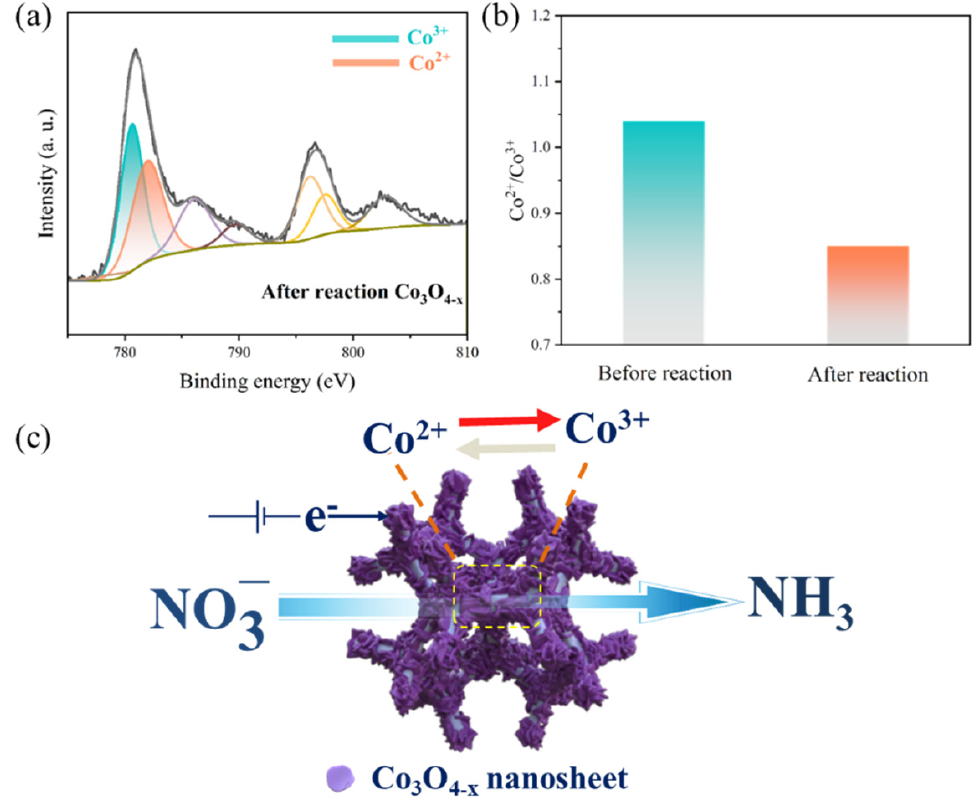
Figure 6. XPS spectra of Co 2p after the reaction ( a ), the Co 2+ /Co 3+ ratio before and after the reaction ( b ), and schematic diagram of the possible reaction mechanism ( c ).